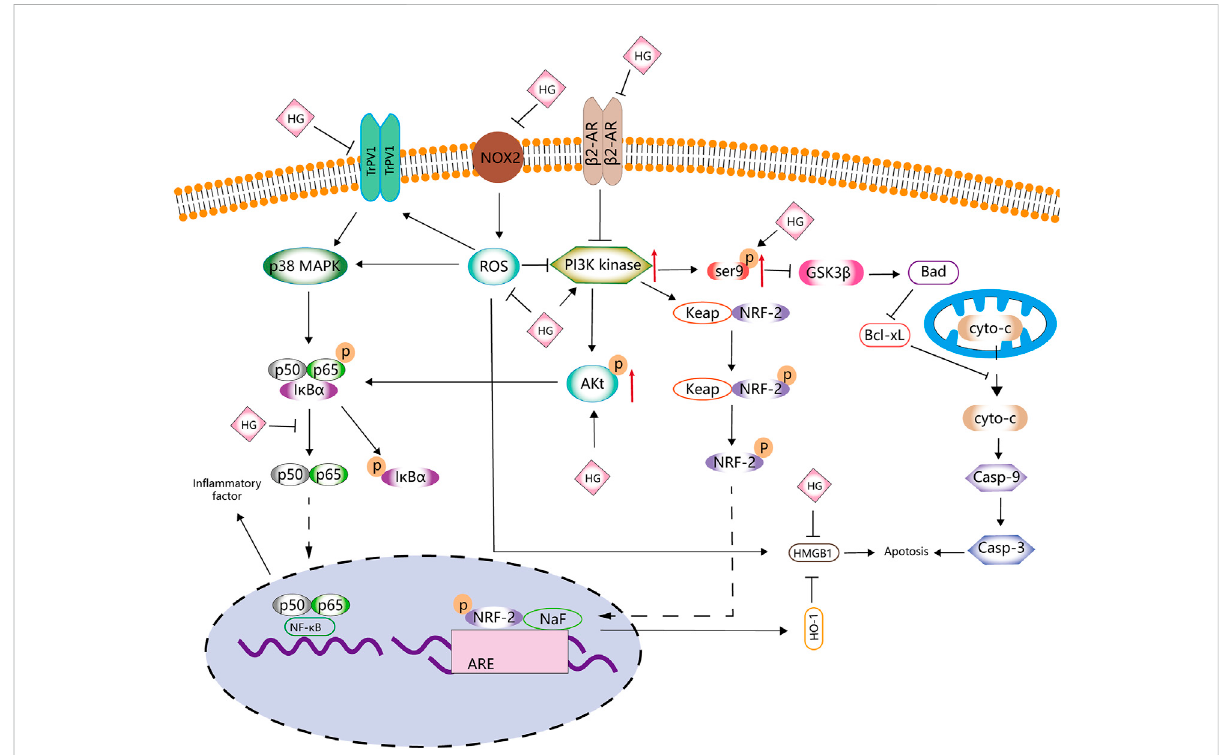
FIGURE 2 Anti-apoptotic and antioxidative effects of HG. HG inhibits apoptosis and antioxidative stress by affecting the PI3K/AKT, NRF2/HO-1, Ser9p/ GSK-3 β , NOX2/ROS, NF- κ B and β 2-AR signalling